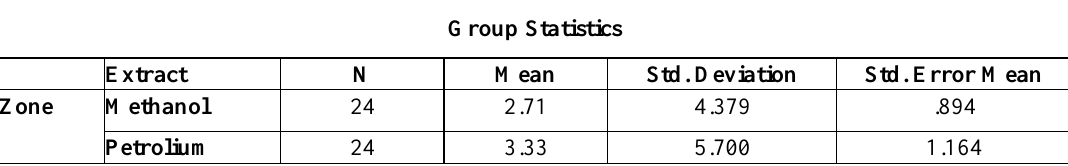
Table 3. T-Test (comparison) between two